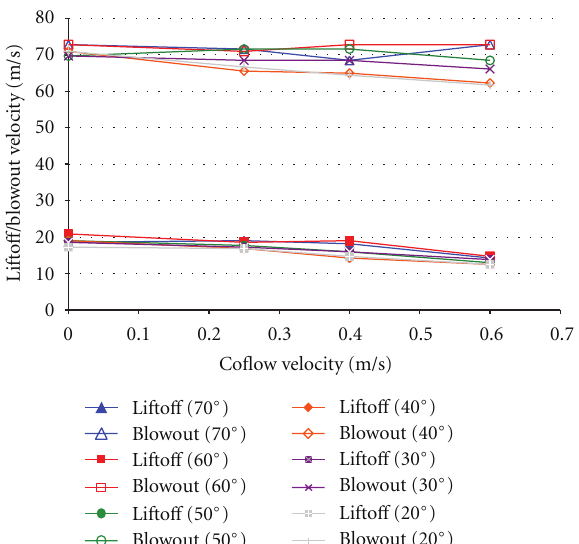
Figure 4: Stability limits versus coflow velocity for all angles.